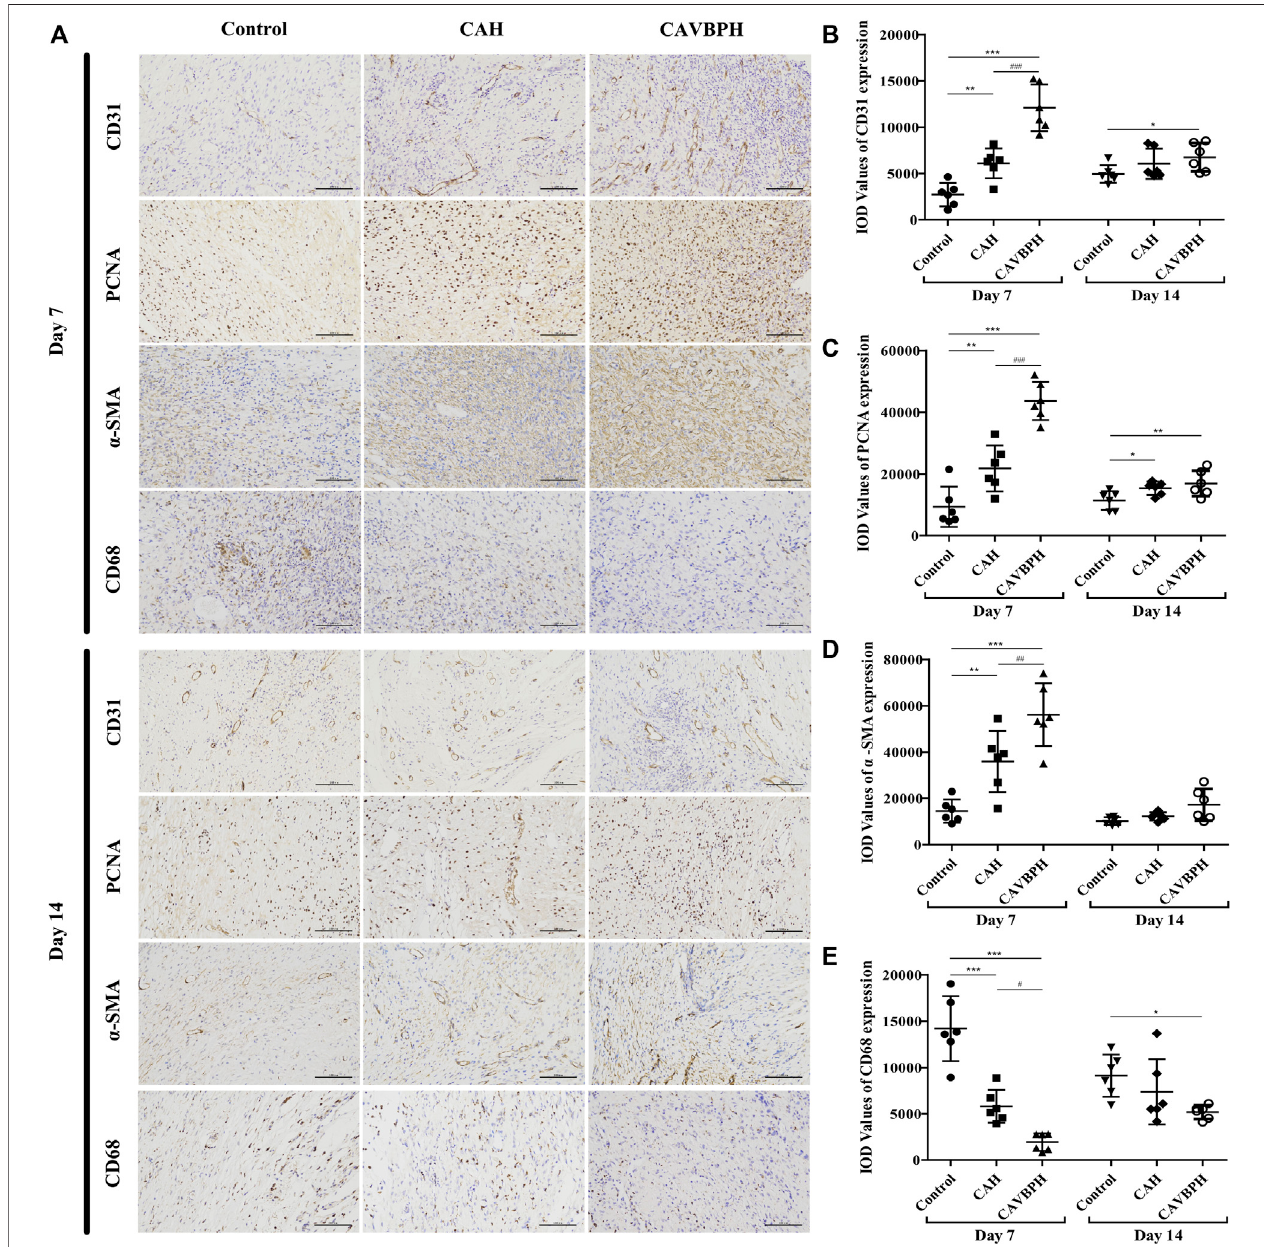
FIGURE5| Immunohistochemistrystainingofwoundtissuesondays7and14. (A) RepresentativeimagesforCD31,PCNA, α -SMA,andCD68staining(scalebar = 100 μ m). (B – E) Quanti fi cation of CD31, PCNA, α -SMA, and CD68 protein expressions, respectively. * p < 0.05, ** p < 0.01, *** p < 0.001 vs . control group; # p < 0.05, ## p < 0.01, ### p < 0.001 vs . CAH group as statistically signi fi